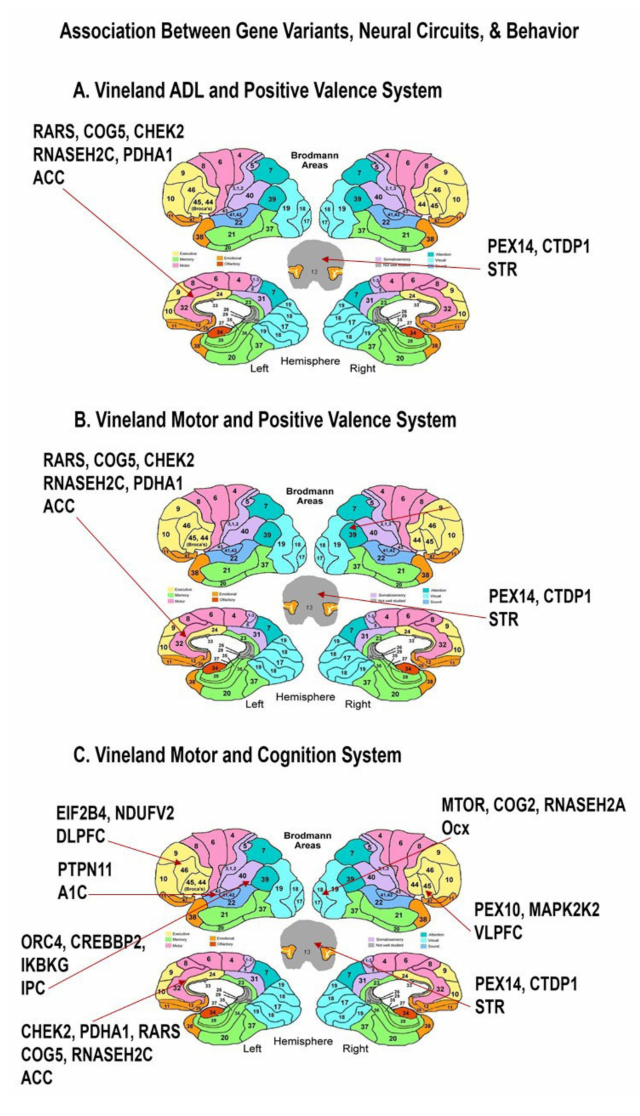
Figure 4. Neural Mapping of Genes Associated with Elevated Vineland Scores . Map of the peak antenatal expression of genes in RDoC neural derived circuits (as defined by NIMH) and elevated